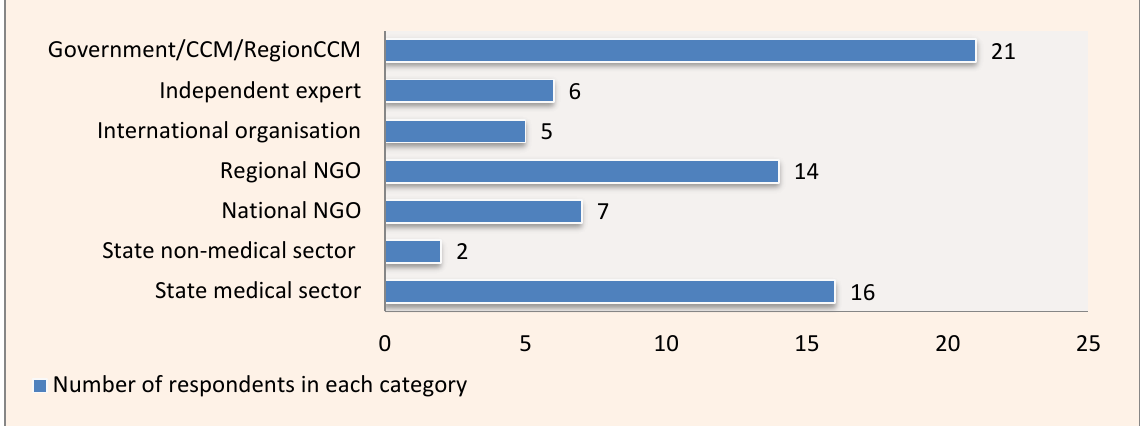
Figure 3. Self-identification of